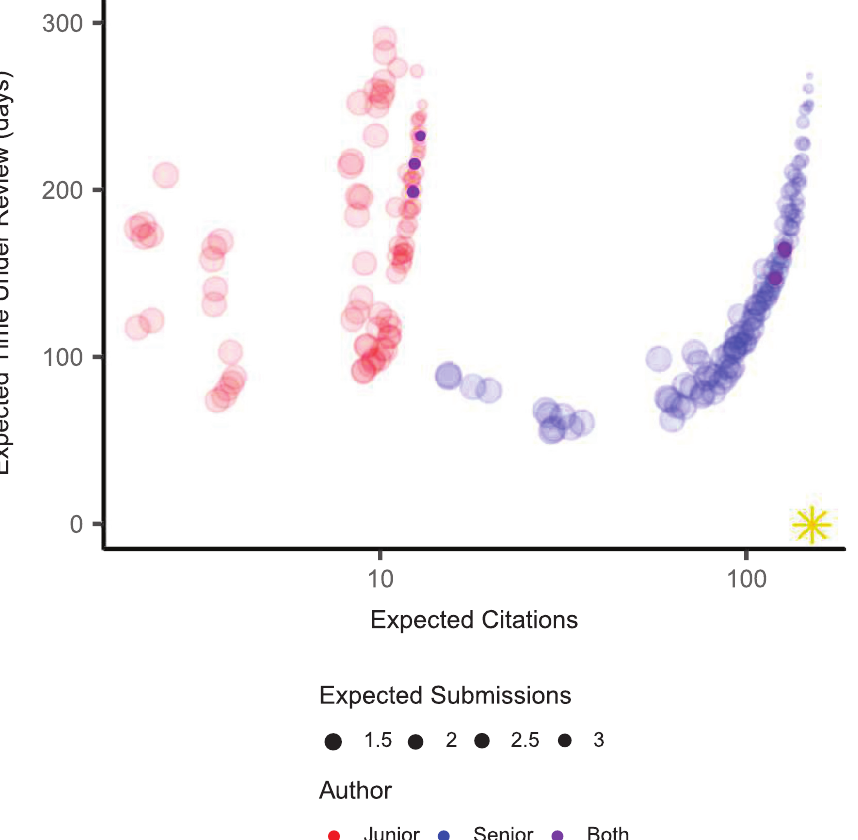
Fig 5. Multiple rationalities can lead to co-author tension. Pareto-approximate solutionsfor a scooping- averse junior researcher( T = 3 years, s = 0.005, t R = 45 days) in red and a less scooping-averse senior researcher ( T = 20 years, s = 0.001, t R = 30 days) in blue. The x -axis (expectedcitations) is plotted on a log scale to highlightthe different ranges of expectedcitations. The gold star in the lower-rightcorner indicates the target directionfor the